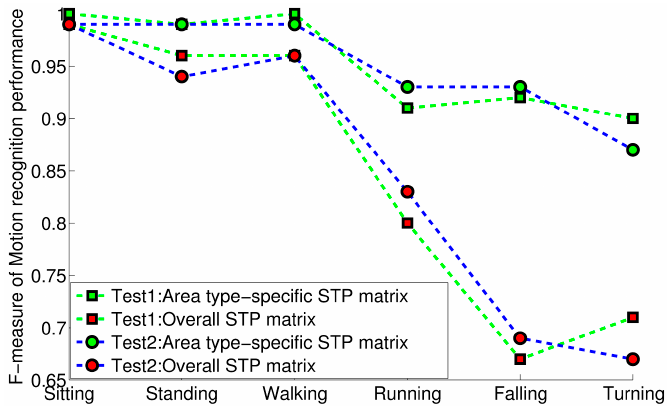
Figure 7. Motion state recognition performance indicated by the F -measure when area type-specific state transition probability matrix and overall STP matrix are utilized